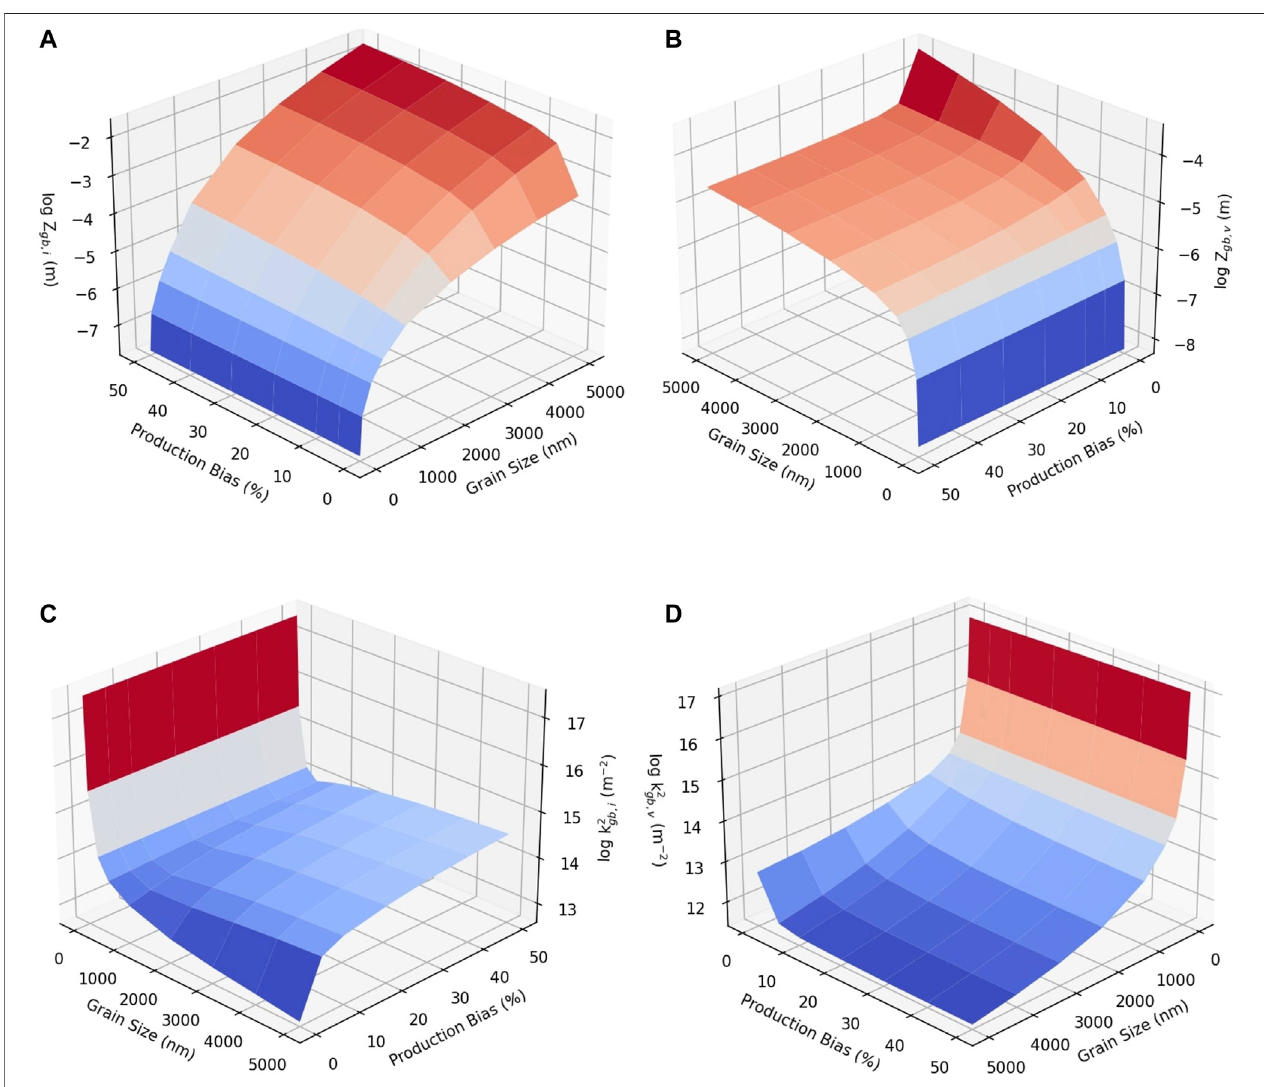
FIGURE 12 | Change of boundary sink strengths with grain size and production bias for 1e-6 dpa/s dose rate in logarithmic scale. Upper row : Individual grain boundarysinkstrengthfor (A) interstitials, Z gb , i ,and (B) vacancies, Z gb , v . Lowerrow :Totalgrainboundarysinkstrengthfor (C) interstitials, k 2 gb , i ,and (D) vacancies, k 2 gb , v